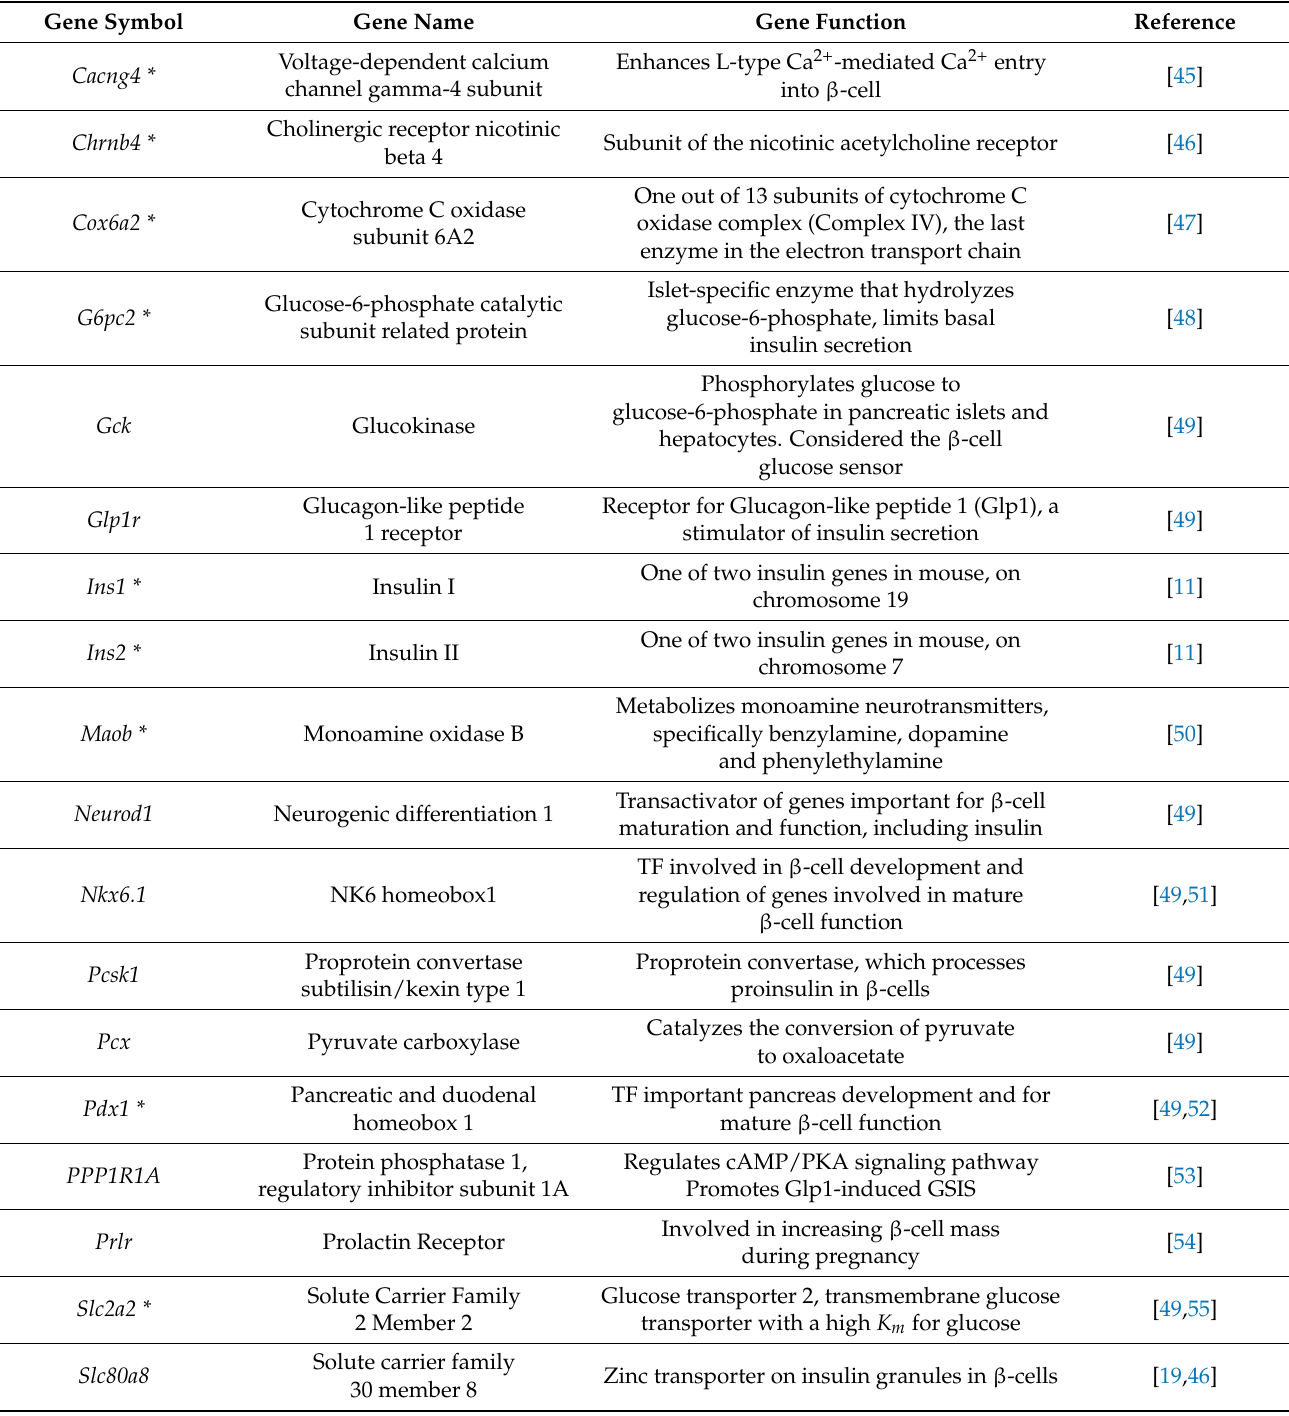
Table 1. MafA target genes. (*) denotes evidence that MafA directly binds target gene